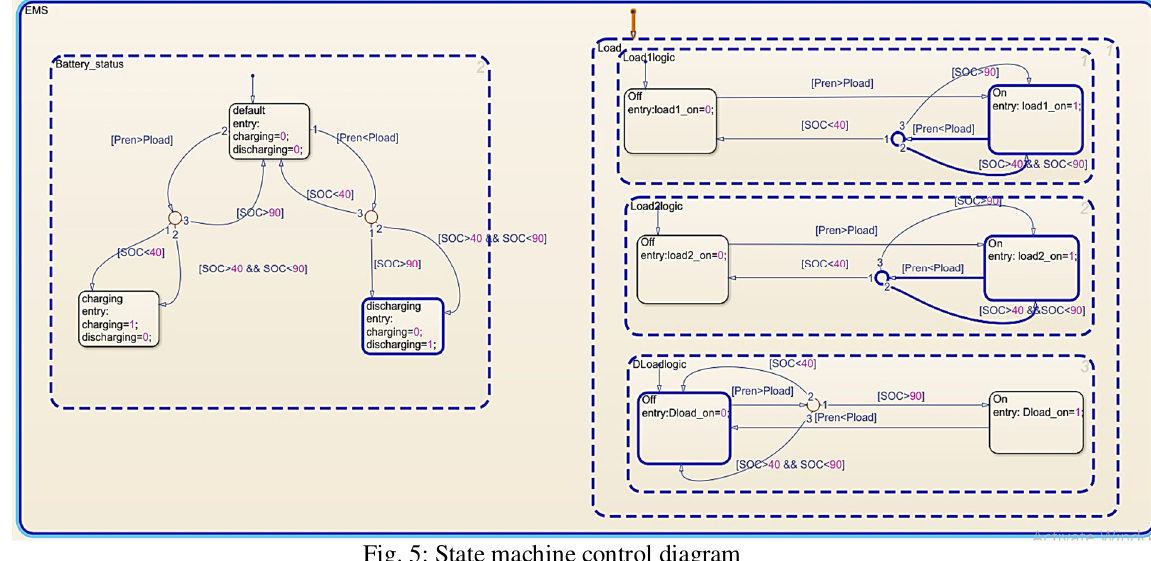
Fig. 5: State machine control